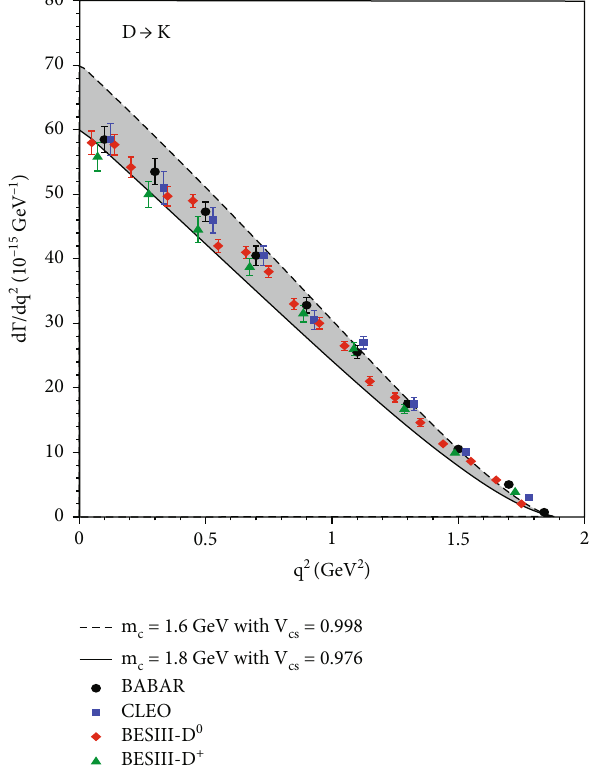
Figure 4: Di ff erential decay rate for the D ⟶ Ke ν decay e compared with the experimental data from the BABAR [67, 68] (black circles), CLEO [69] (blue squares), and BES III [13, 14] for neutral D 0 (red diamonds) and charged D + with the account of isospin factor (green triangles). ℓ = e , μ ) Table 5: Branching ratios (in 10 − 3 ) for D ⟶ π ℓ ν ℓ ( = 1 : 7 +0 : 1 ∣ V ∣ = 0 : 221 obtained from using m − 0 : 1 GeV together with c cd ± 0 : 004 [62].